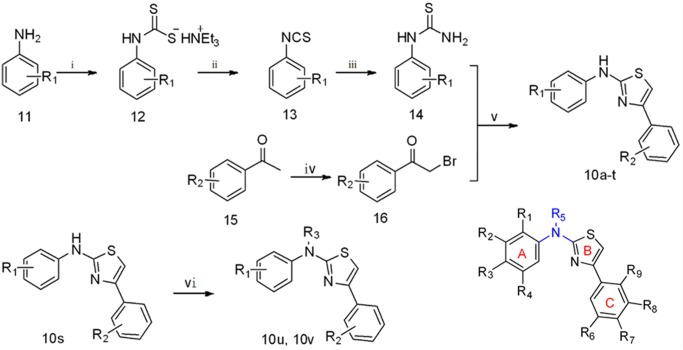
Reagents and conditions. (i) CS2, Et3N, Et2O, 25°C; (ii) I2, Et3N, EtOAc, 0°C; (iii) NH3·H2O; (iv) CuBr2, CHCl3, EtOAc; (v) EtOH, MW 80°C; (vi) 1) CH3I, DMF, 25°C or 2) Ac2O, 50°C.